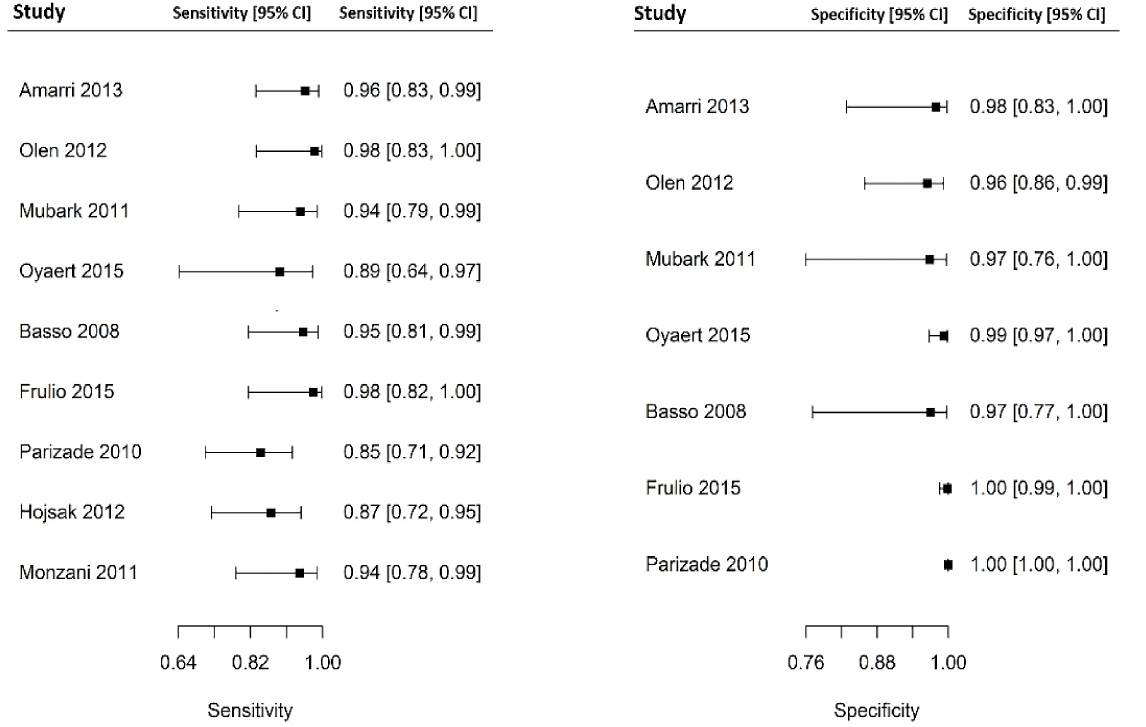
Figure 3. Forest plot for sensitivity and specificity of immunoglobulin A anti-tissue transglutaminase antibody (TTG IgA)